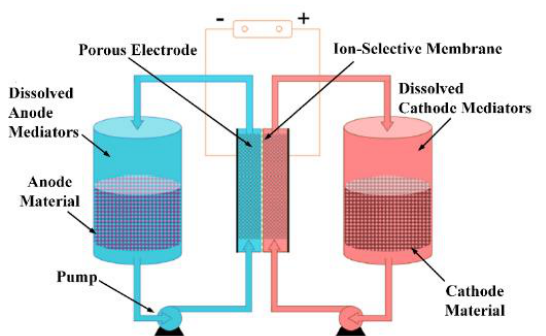
Figure 58. Schematic illustration of Type IV RFB design, which uses targeted redox mediators as the power carriers with static solid active materials providing energy storage [161].